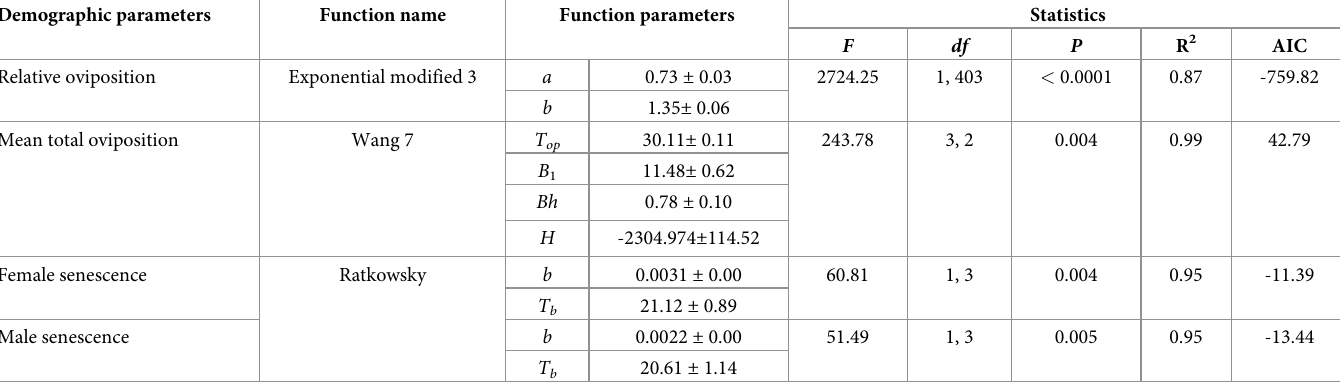
Table 4. Statistics of the goodness of fit and parameters of functions with their approximate standard errors fitted to describe the relationship between Diachasmi- morpha longicaudata cumulative oviposition, mean oviposition, and adult senescence and